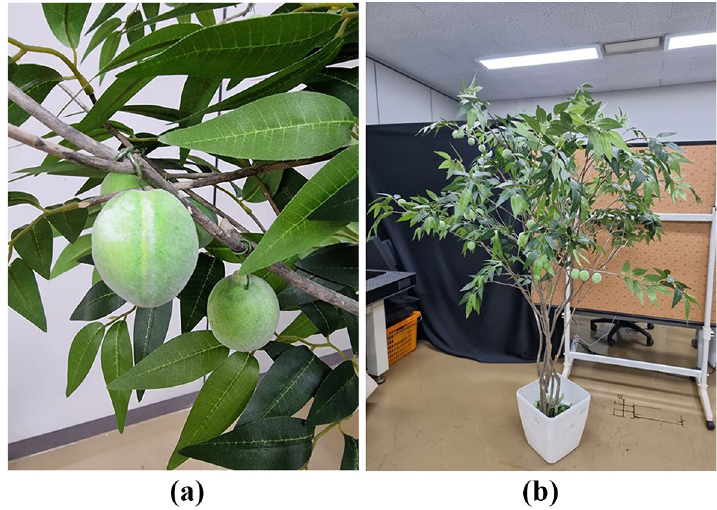
Figure 10. Indoor configuration of artificial prunus mume : ( a ) fruits; ( b ) tree.